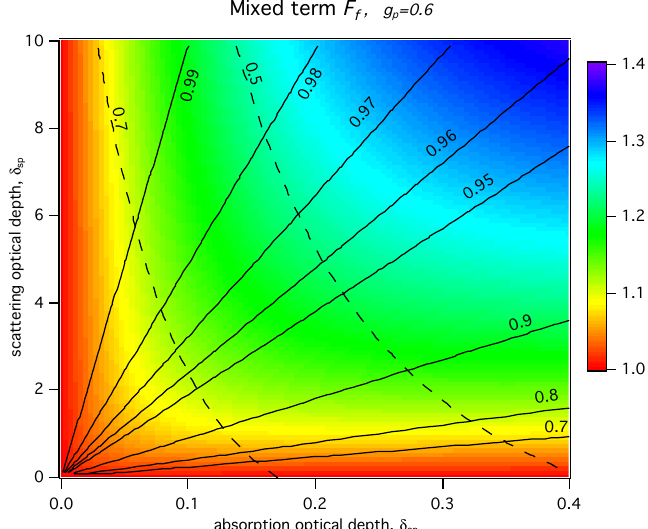
Figure 7. Mixed-term F f versus scattering and absorption optical depth for a particle asymmetry parameter of 0.6. Shown are lines for single-scattering albedos (solid lines) from 0.7 to 0.99 and for relative transmittances (dashed lines) of 0.5 and